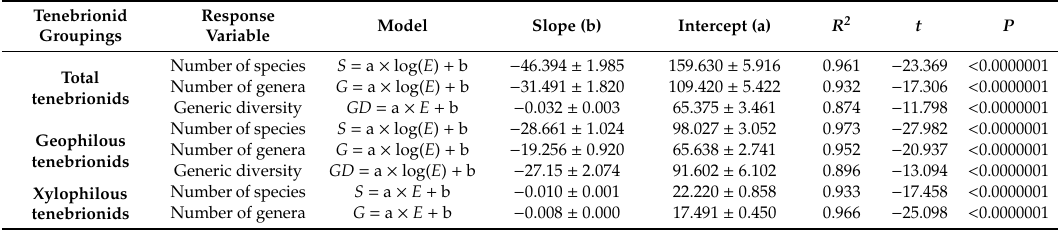
Table 1. Results of OLS regression models for the number of tenebrionid species ( S ) and genera ( G ), and generic diversity ( GD ) as function of elevation ( E ). Errors refer to Standard Errors. R 2 = goodness-of-fit, t = Student’s t